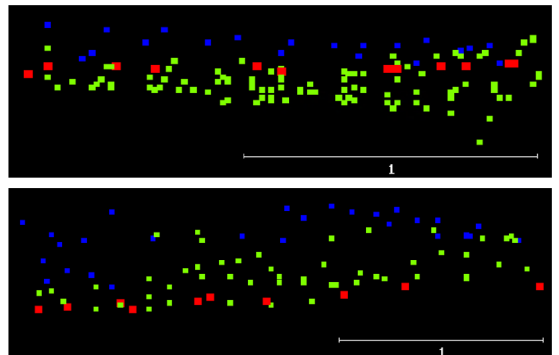
Figure 6. Profiles of three point clouds: ALS points (red), SURE ground points identified by LASground (green) and non-ground points (blue). Top: Profile of the line on paved ground; Bottom: Profile of the line on